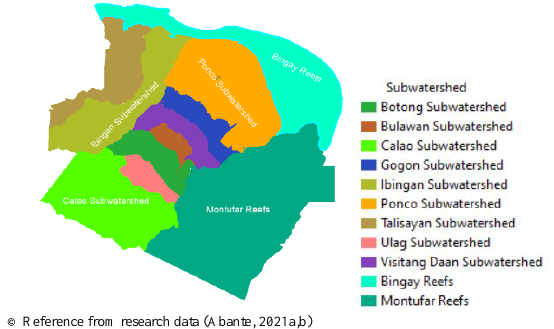
Figure 5 . Subwatershed spatial (polygon) element